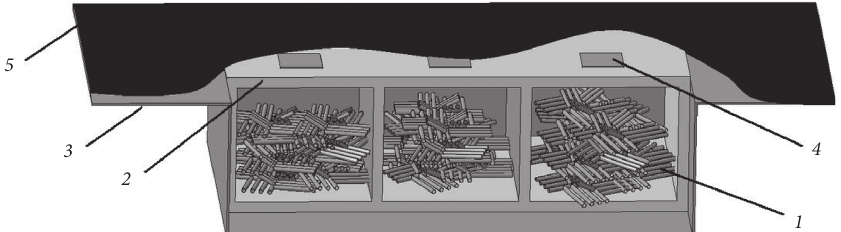
Figure 2: Appearance of the bunker (concrete) storage: 1, graphite radioactive waste; 2, reinforced concrete floors; 3, adjacent engineering structures; 4, reinforced concrete cork; 5, external screen (asphalt).